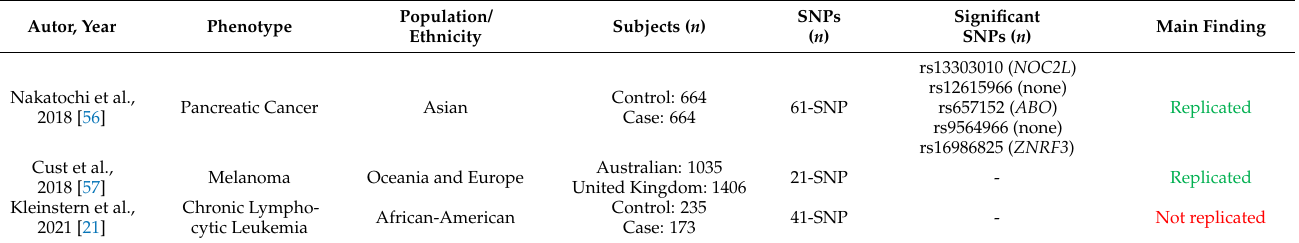
Table 3. Polygenic risk scores established for other cancer types in multiethnic